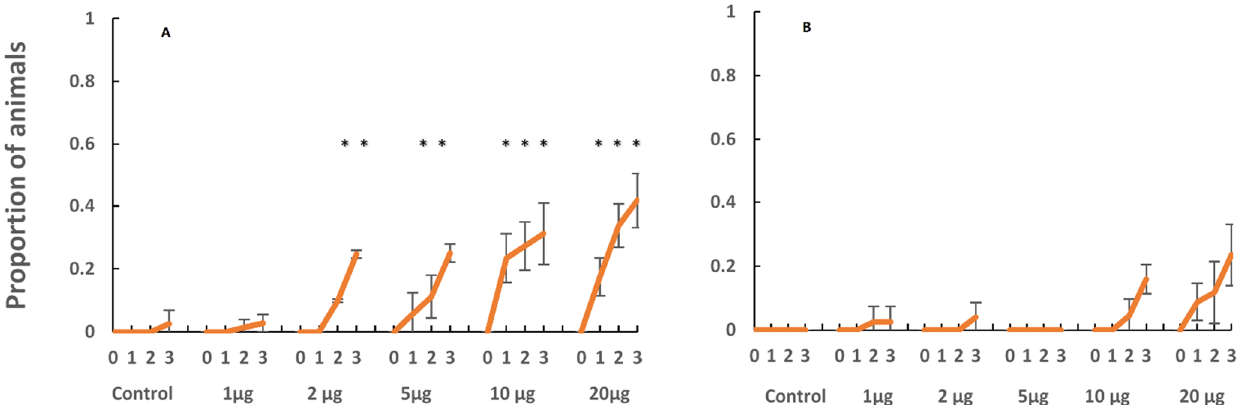
Figure 5. Settlement and metamorphosis into polyps of C. xamachana ( A ) and C. frondosa ( B ) in response to the inducer Z-GLY-PRO-GLY-GLY-PRO-ALA-OH for 0, 1, 2, or 3 days. Mean ± s.d. (n = 4). The proportion of metamorphosed polyps of C. xamachana were significantly higher (*, comparison of means) than metamorphosed polyps of C. frondosa.